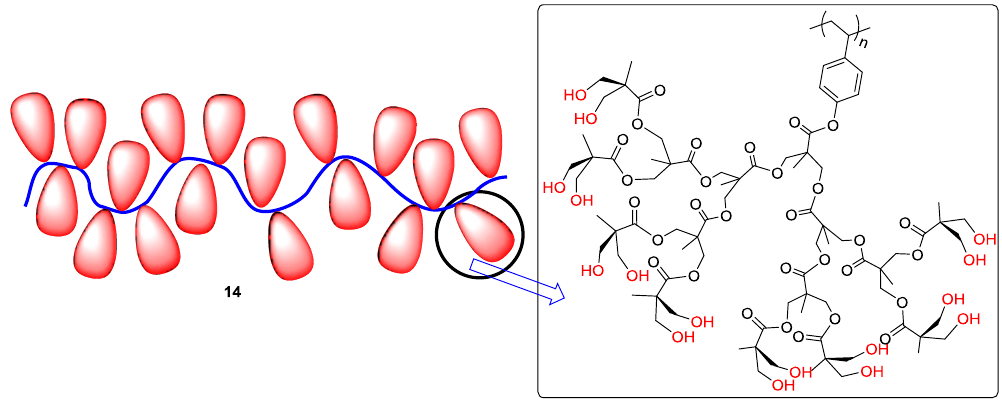
Figure 5. A representation of a dendronized linear polymer and the structure of fourth-generation dendronized poly(4-hydroxystyrene)